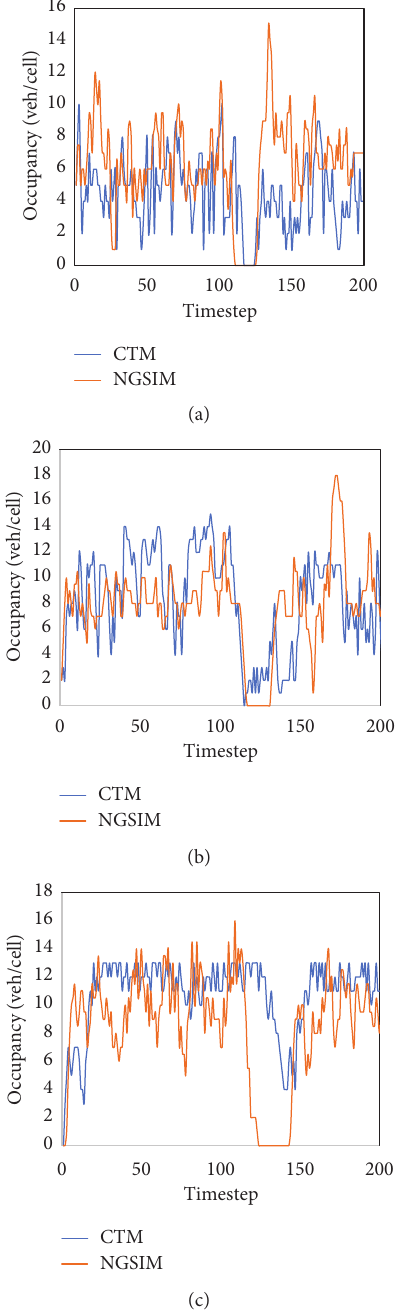
Figure 13: Comparison of the occupancies between CTM and I80 in specific cells: (a) C2L1, (b) C3L2, and (c)